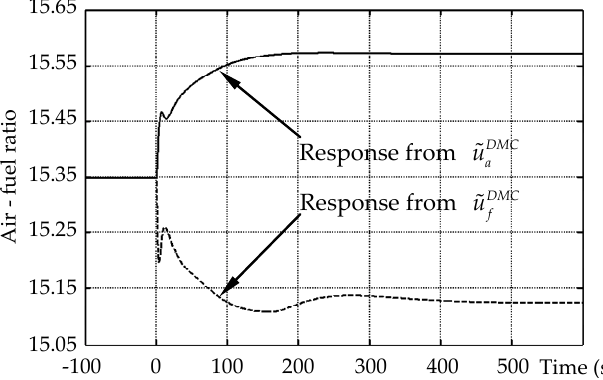
Figure 5. Step responses in a 600 MW power plant.